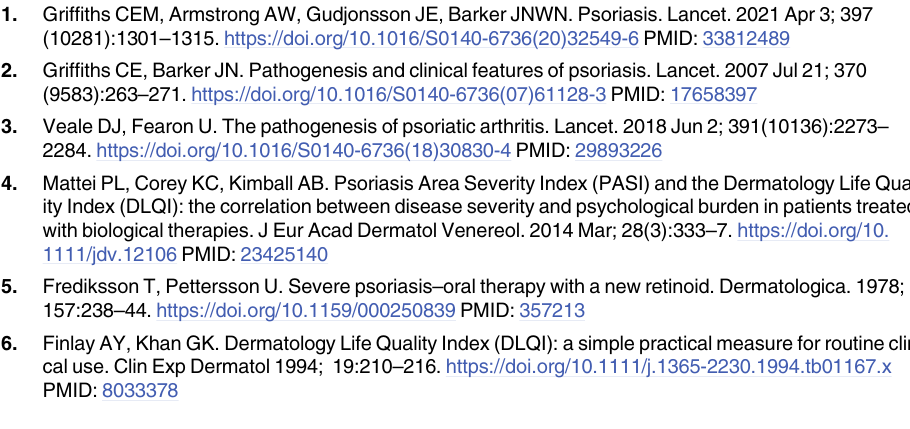
S2 Table. Dermatology Life Quality Index measurement of social activities during COVID-19